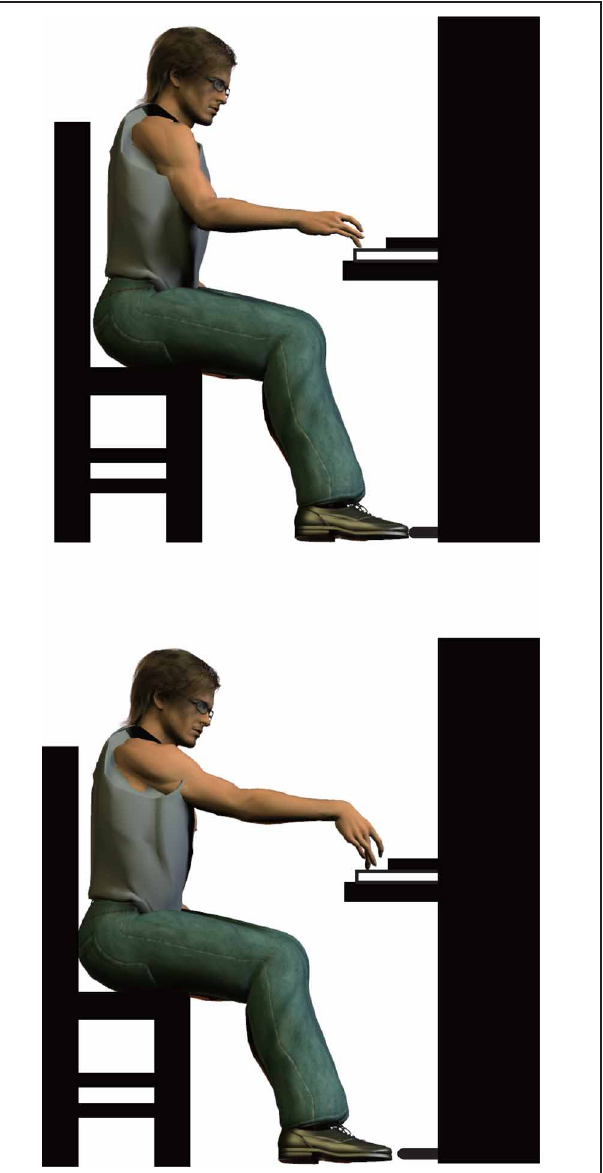
FIGURE 2 | An example that describes the kinematic redundancy. A fingertip motion cannot uniquely specify the joint kinematics due to the redundancy of the